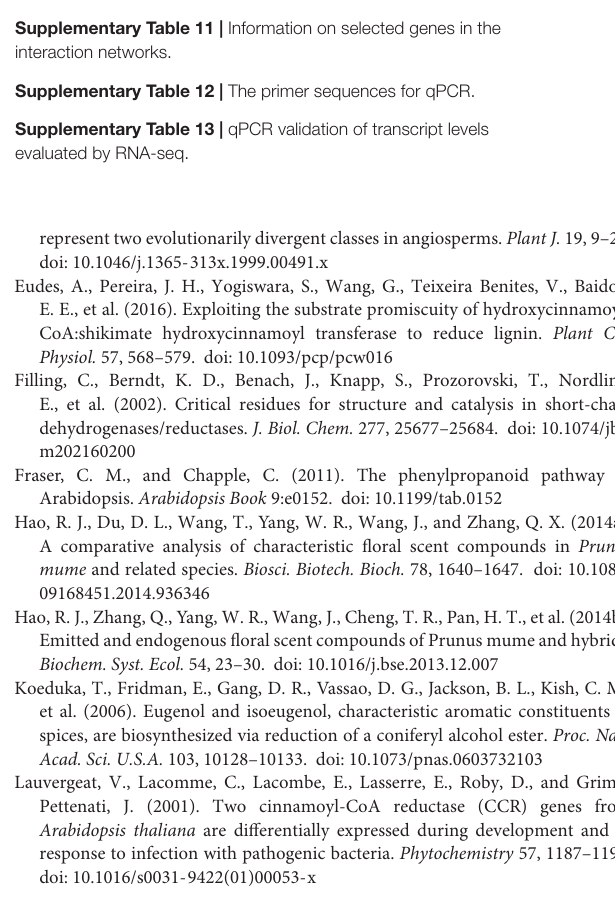
Supplementary Table 5 | Gene structure annotations of novel genes. Supplementary Table 6 | . Novel isoforms of known genes. Supplementary Table 7 | Information on the key enzymes in the floral scent synthesis pathway.